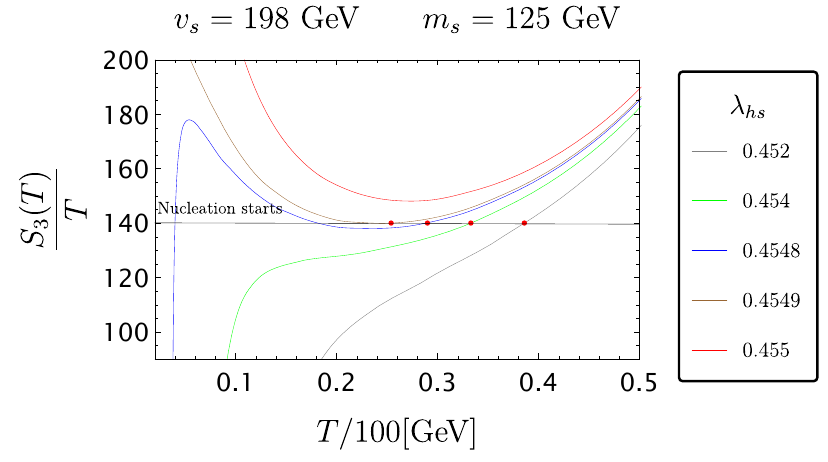
Figure 13 . On this plot we show the regime of transition. We observe that several points display a disappearance of the barrier which is typical of the regime of no barrier at T = 0 . However, the nucleation temperature is controlled by the first minimum of S 3 /T , which is typical of the regime with a barrier at T = 0 .